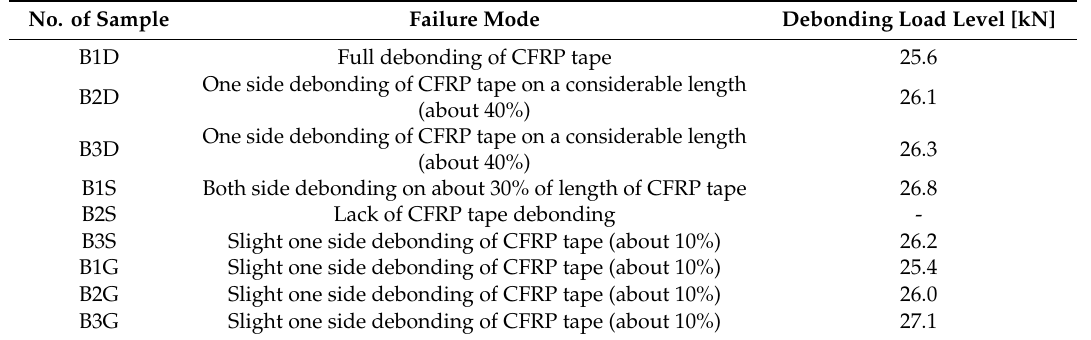
Table 1. Form of sample failure mode.